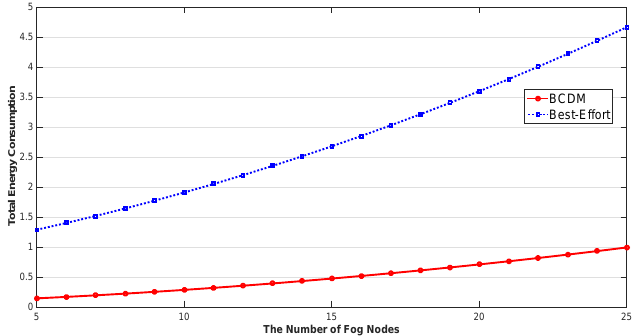
Figure 13. The Impact of the Number of Fog Nodes to Total Energy